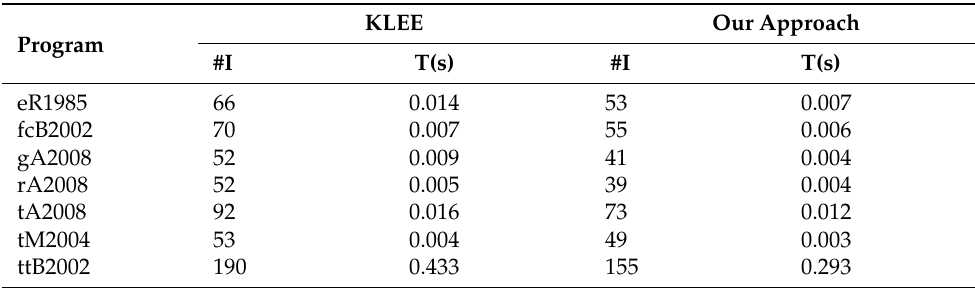
Table 5. Comparison of KLEE (using SSA) and the proposed approach’s (using minimal SSA) times for generating paths among the test